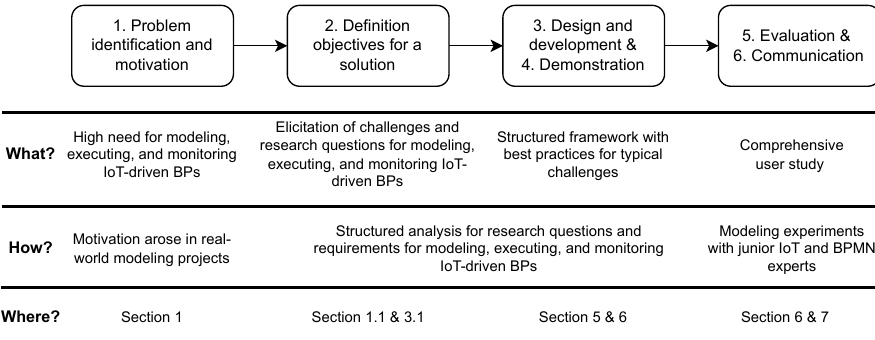
Figure 2. Design Science Research Methodology applied in this